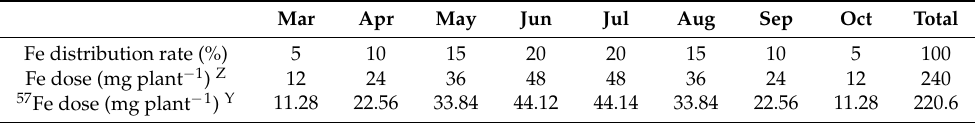
Table 7. Fe and 57 Fe doses and its monthly distribution along the fertilizing period in citrus